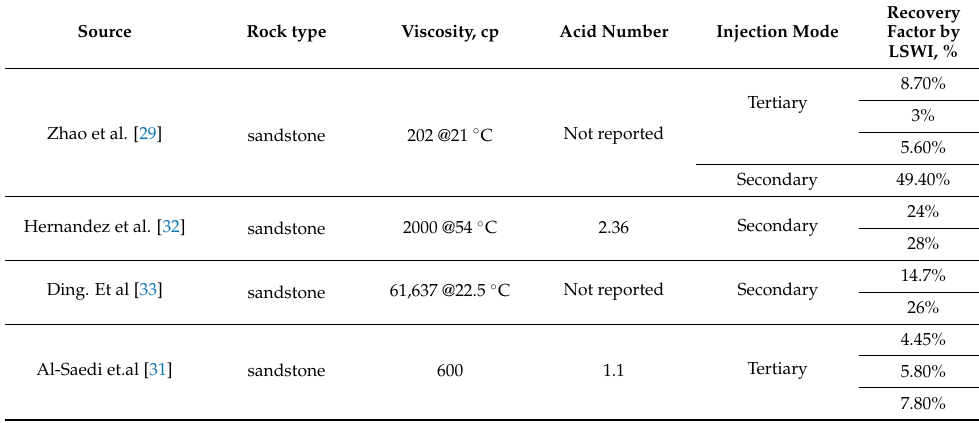
Table 4. Data reported in the literature for the LSWI to heavy oil